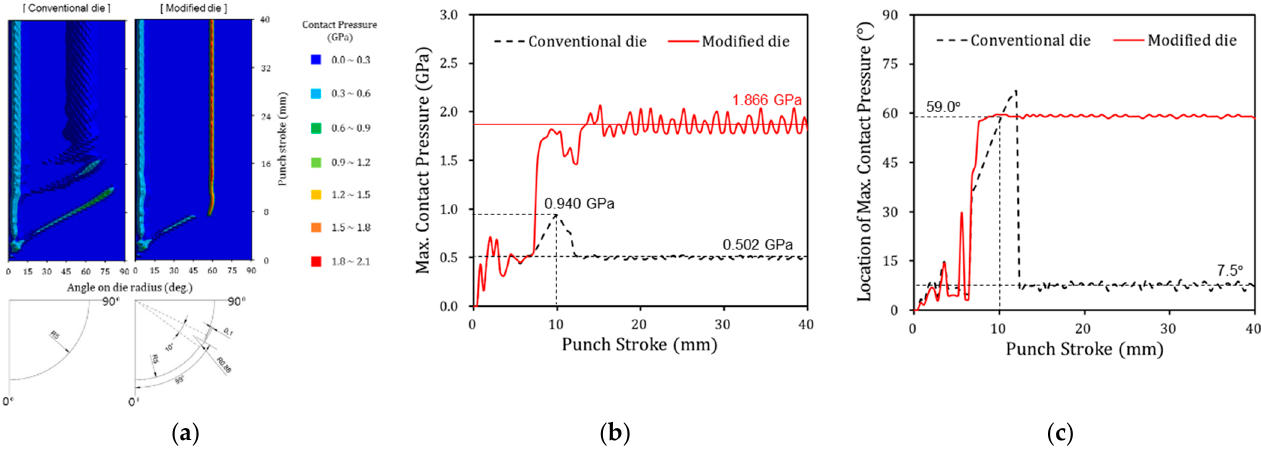
Figure 11. Contact conditions on the die radius: ( a ) contact pressure distribution; ( b ) maximum contact pressure; ( c ) location of the maximum contact pressure.